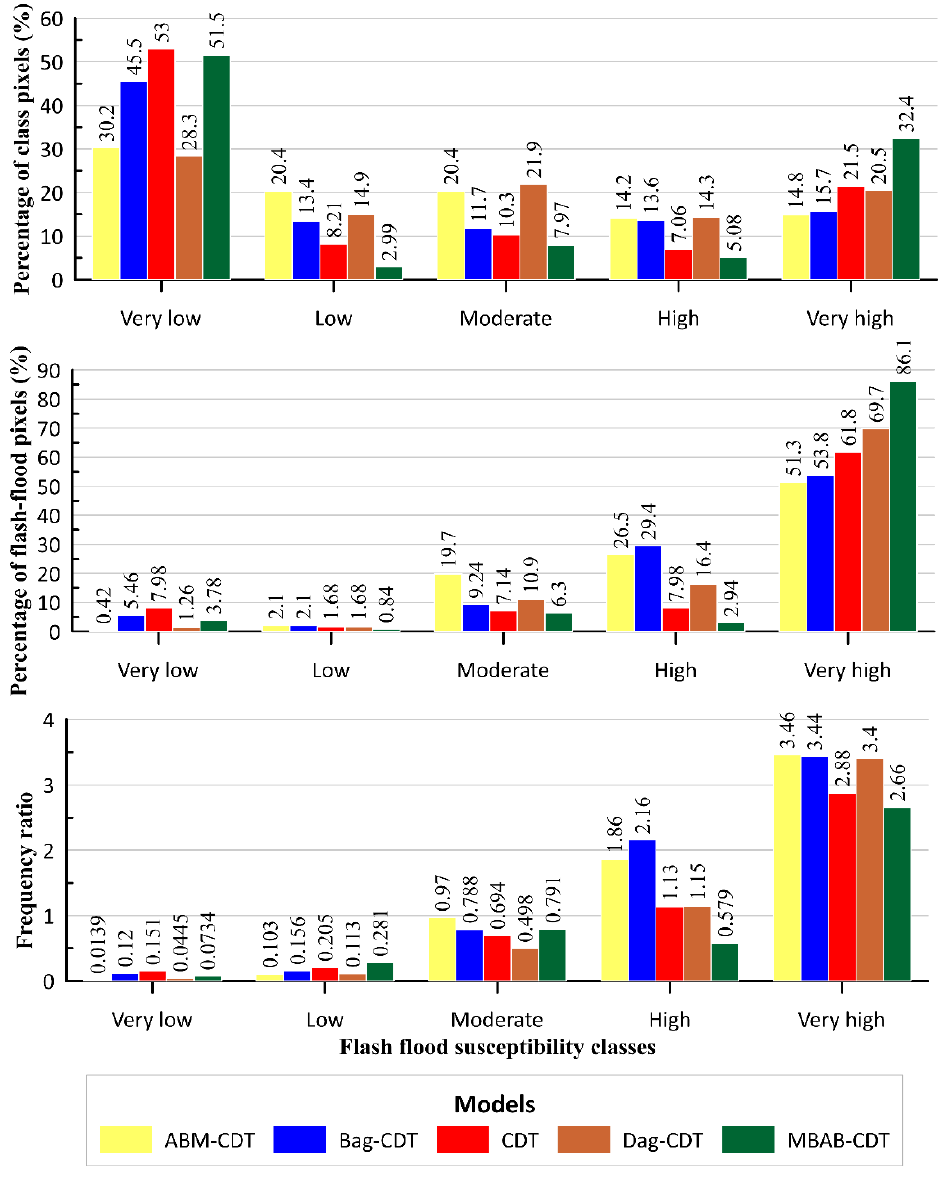
Figure 11. Analysis of performance of flash flood susceptibility maps using different models.